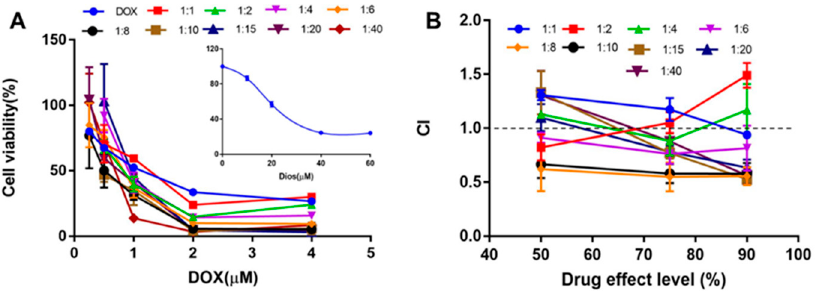
Figure 5. The synergistic effect of DOX and Dios on HepG2 cells. ( A ) The cell viability of different proportions of DOX + Dios on HepG2 cells; ( B ) CI values of DOX + Dios in different proportions. Table 3. IC 50 of DOX, Dios-LP, CHOL-DOX-LP and Dios-DOX-LP ( μ M).